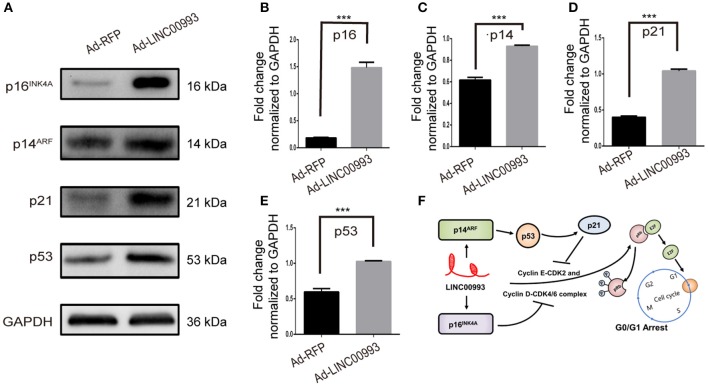
LINC00993 regulates cell cycle-related genes. (A) Western blot bands show cell cycle-related proteins infected by LINC00993 overexpression. Integrated optical density (IOD) was measured by Photoshop. The experiment was performed at least three times independently. (B–E) Bar graph for Western blot results of p16INK4A, p21, p14ARF, p53 from (A). ***P < 0.001 based on Student's t-test. Data were presented as mean ± SEM. (F) Schematic model of LINC00993 in breast cancer. LINC00993 upregulates p16INK4A, p14AR, inducing G0/G1 arrest via E2F pathway.